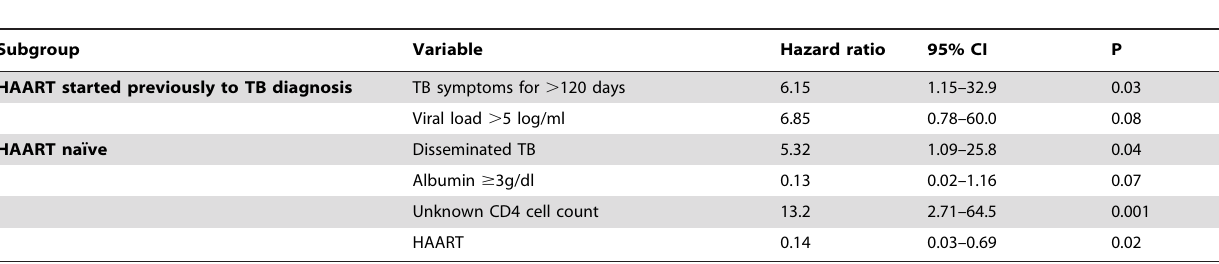
Table 5. Multivariate Analyses of Factors Associated with Early Tuberculosis-Related Mortality in Subgroups Defined According to the Baseline Status of HAART